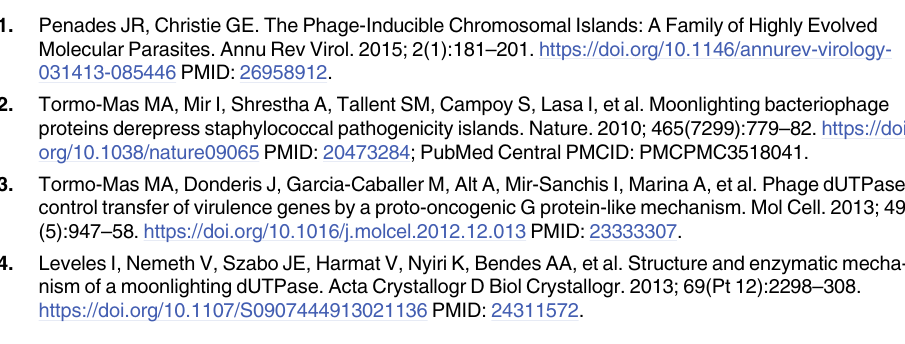
S5 Table. Plasmids used in this study.